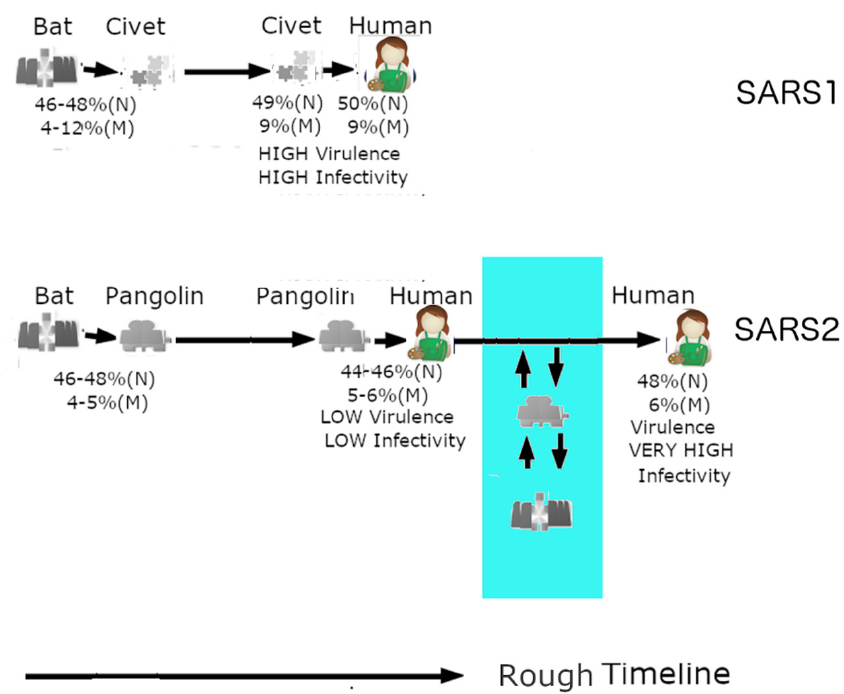
Figure 5. Zoonotic relationships of SARS-CoV-1/2. SARS-CoV-1 (SARS1) was likely in an interme- diary host (palm civet cat) for a relatively short period, which could account for its high virulence. SARS-CoV-2 (SARS2), on the other hand, could have been in pangolins for a long period of time and thus first entered as an attenuated strain. Omicron had the opportunity to retain its attenuation by a reverse zoonotic transfer back to a burrowing animal (in blue).